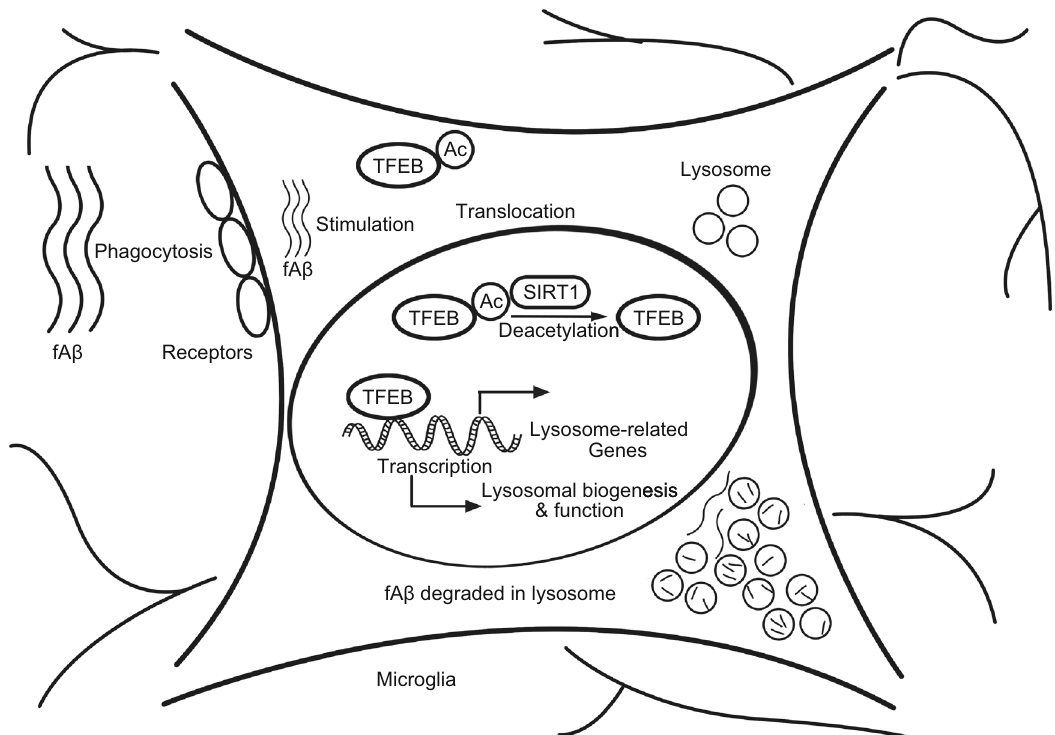
Figure 8. A schematic model of TFEB deacetylation on facilitating fA β degradation in microglia by enhancing lysosomal biogenesis. In the presence of fA β stimulation, microglia take up fA β and transport them into lysosomes. Meanwhile, TFEB translocates into nucleus where it interacts with SIRT1 and is deacetylated at K116. Deacetylation of TFEB enhances its transcriptional induction of its downstream target genes closely associated with lysomomal biogenesis, which eventually